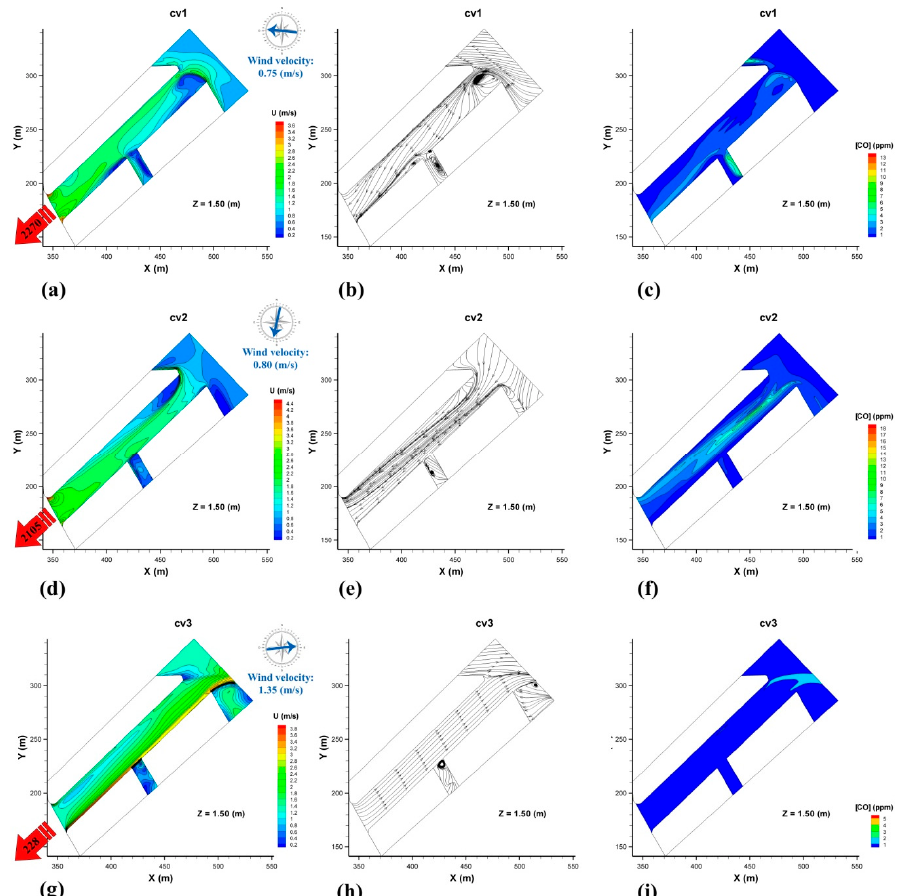
Figure 5. Contour velocity planes ( a , d , g ), streamlines ( b , e , h ) and contour planes of CO concentration ( c , f , i ) for cv1, cv2 and cv3 validation cases, respectively. The planes were located at 1.5 m of height. Traffic and wind direction are marked with red and blue arrows, respectively. Traffic intensity and velocity are specified in their respective arrows.